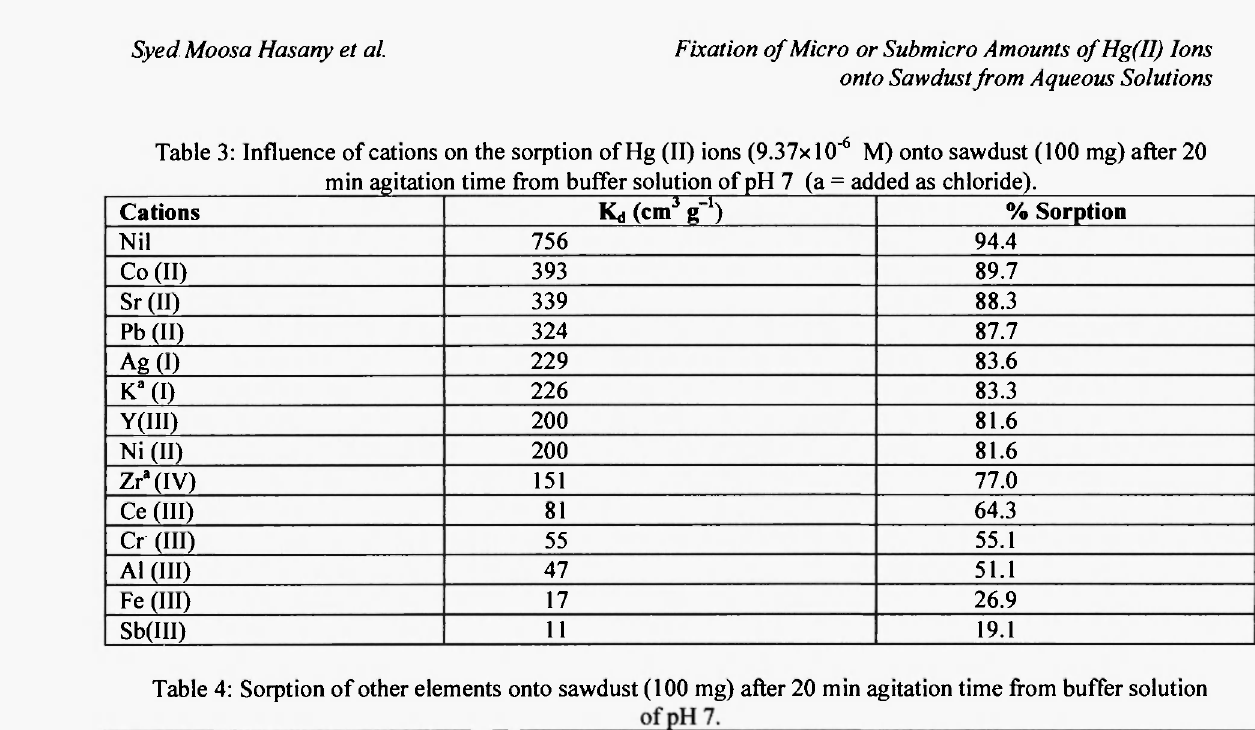
Table 4: Sorption of other elements onto sawdust (100 mg) after 20 min agitation time from buffer solution Metal ions Kd (cm 3 g" 1